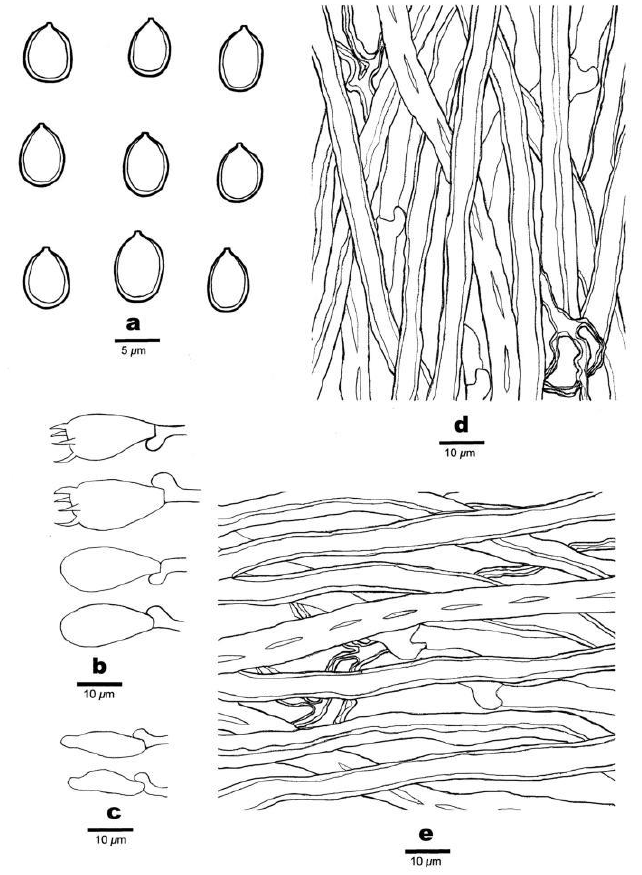
Figure 4 . Microscopic structures of Poriella subacida ( Holotype ). ( a ) Basidiospores . ( b ) Basidia and basidioles . ( c ) Cystidioles . ( d ) Hyphae from trama . ( e ) Hyphae from context . Bars : A = 5 µm; B – E = basidioles. ( c ) Cystidioles. ( d ) Hyphae from trama. ( e ) Hyphae from context. Bars: A = 5 µ m; 10 µm . B–E = 10 µ